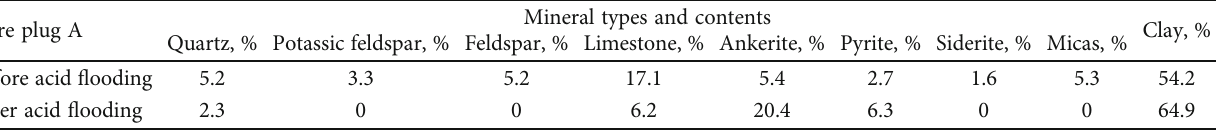
Figure 6: XRD result of A1 core after fl ooding. Table 2: The mineral content comparison of A1 core before/after acid fl ooding.